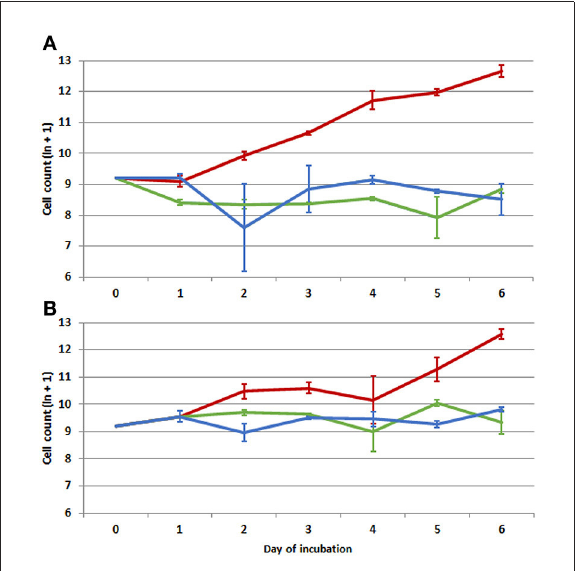
FIGURE1 Development in counts of macrophages (ln-transformed) during (A) culturing at different temperatures (8, 17.5, and 37 ◦ C) in Experiment 1 and (B) culturing at different temperatures (8, 17.5, and 37 ◦ C) after preincubation at 37 ◦ C (0–1 day) in Experiment 2. Red line- − 37 ◦ C, green line- − 17.5 ◦ C, blue line- − 8 ◦ C. Generalized linear models (GLM) analysis for 3 replicates/3 repetitions indicates influence of temperature (GLM, W = 50.74, p < 0.001) and cultivation day (GLM, W = 11.67, p = 0.070) on cell number in Experiment 1 and influence of temperature (GLM, W = 35.31, p < 0.001) and cultivation day (GLM, W = 14.00, p = 0.016) in Experiment 2. Average data and standard deviation (error bars) at each day of incubation shown based on 3 replicates/3 repetitions, n = 9.